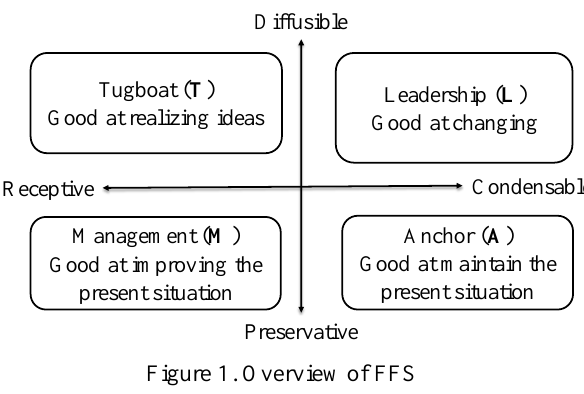
Figure 1. Overview of